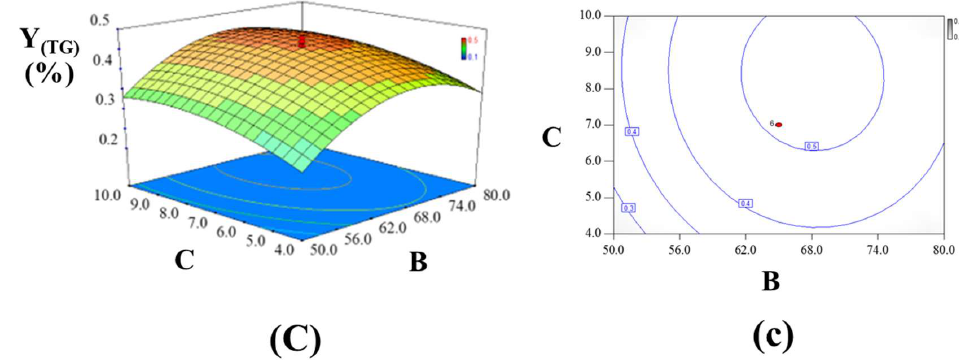
Figure 4. Three-dimensional contour plots showing the experimental factors and their mutual interactions: ( A ) effect of UAE power and EtOH% on the yield of ginkgolides; ( B ) effect of UAE power and the amount of cellulase on the yield of ginkgolides; and, ( C ) effect of EtOH% and UAE power on the yield of ginkgolides. Two-dimensional contour plots showing the experimental factors and their mutual interactions: ( a ) effect of UAE power and EtOH% on the yield of ginkgolides; ( b ) effect of UAE power and the amount of cellulase on the yield of ginkgolides; and, ( c ) effect of EtOH% and UAE power on the yield of ginkgolides.